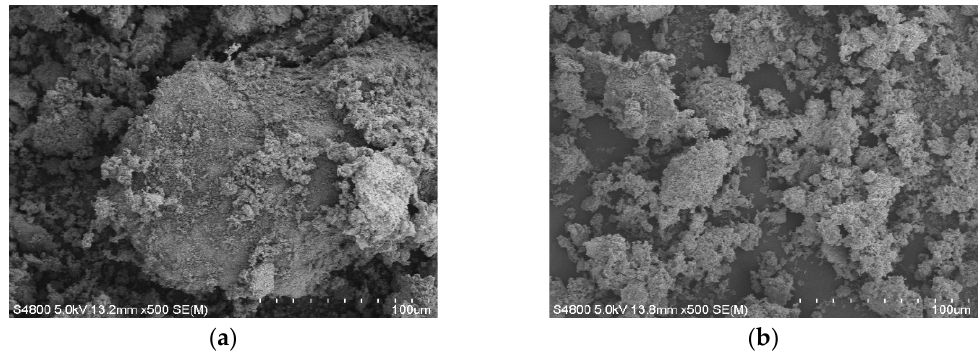
Figure 1. SEM of unmodified manganese sand ( a ) and modified manganese sand ( b ).